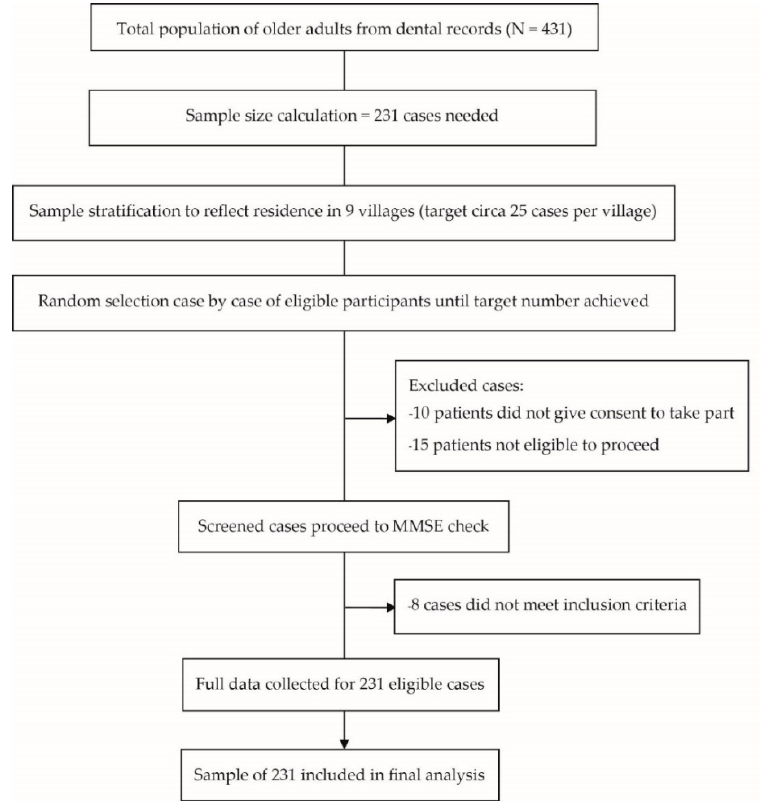
Figure 1. Sample collection flow chart.